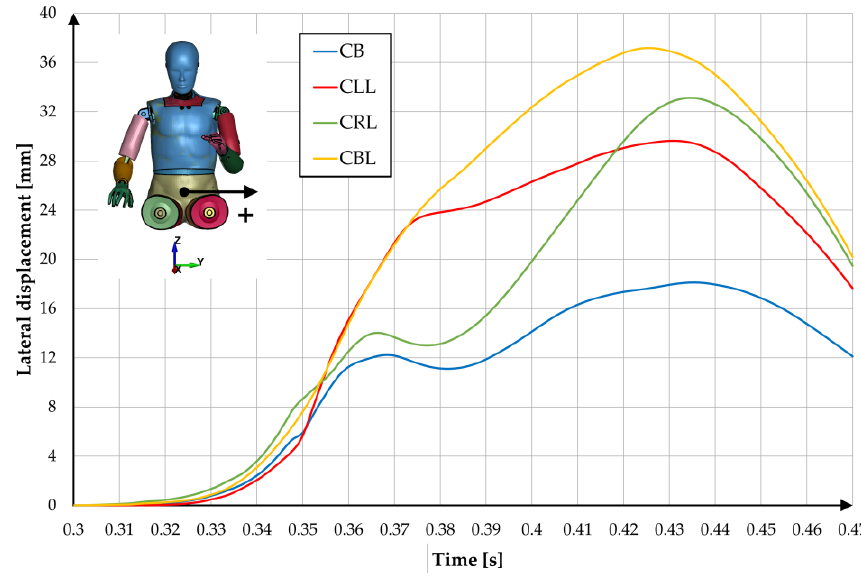
Figure 10. Lateral displacement of dummy H-point.